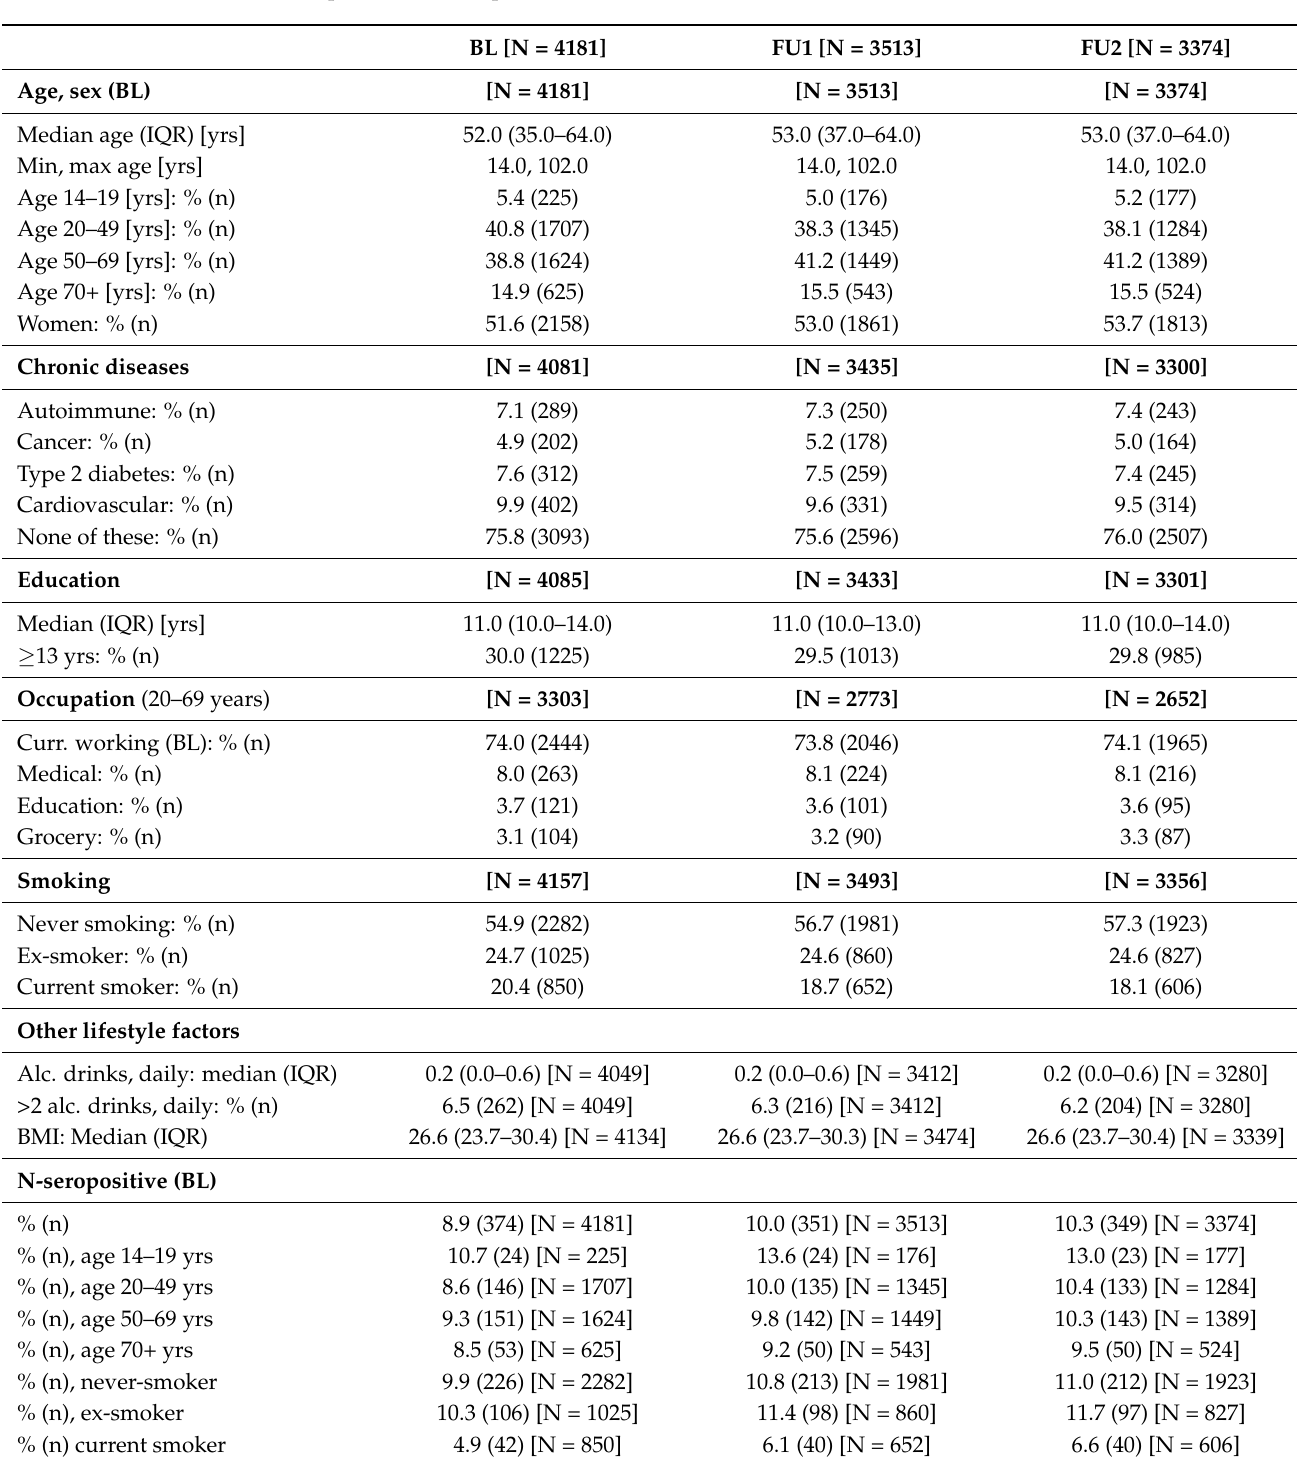
Table 1. Participant characteristics at baseline and follow-up. For the participants at baseline (BL) and the two follow-ups (FU1, FU2), descriptive statistics are shown by characteristics (median and interquartile range, IQR, or proportions and absolute numbers) [and number of individuals with valid information]. All characteristics are self-reported, except N-seropositivity (i.e., proportion of positives for N-specific antibodies, cut-off = 1.0